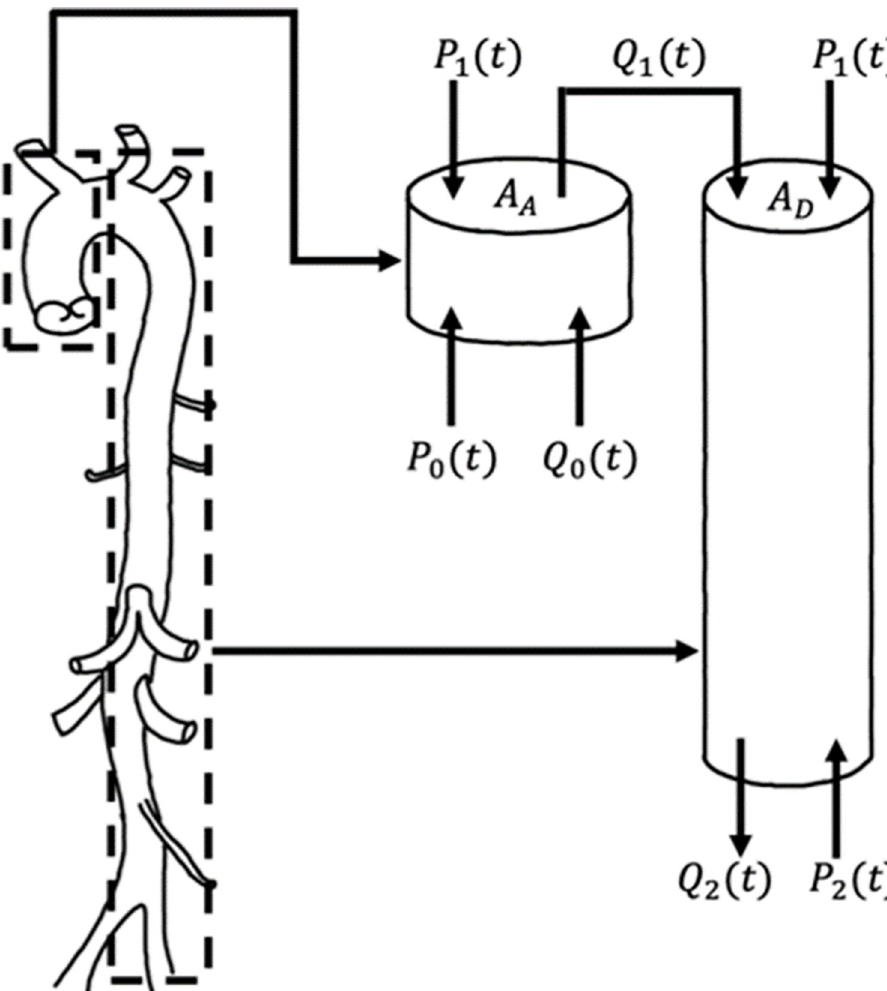
Fig 1. Model of heartbeat mechanism and changes in force